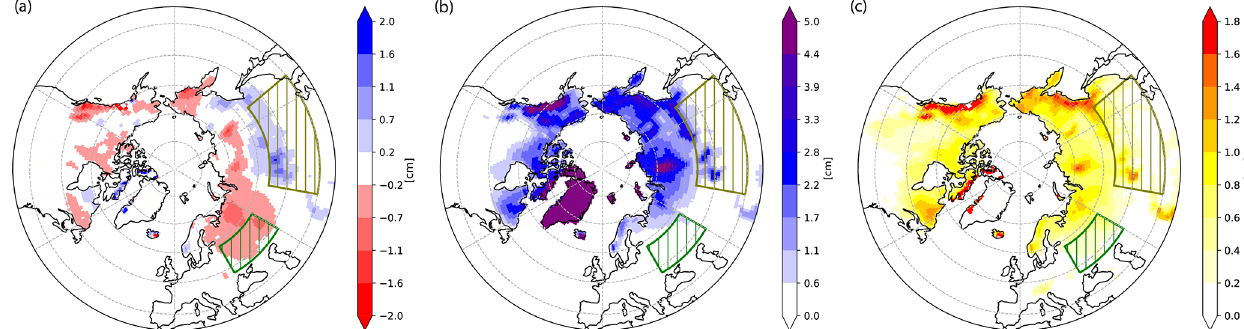
Figure 3. (a) Average (1900–2010) 1 November snow depth difference between the high-dipole and low-dipole ensemble. (b) Average (1900–2010) 1 November snow depth. (c) Average (1900–2010) 1 November snow depth standard deviation. Hatched in green (olive) is the western (eastern) domain of the snow index. All three plots are based on